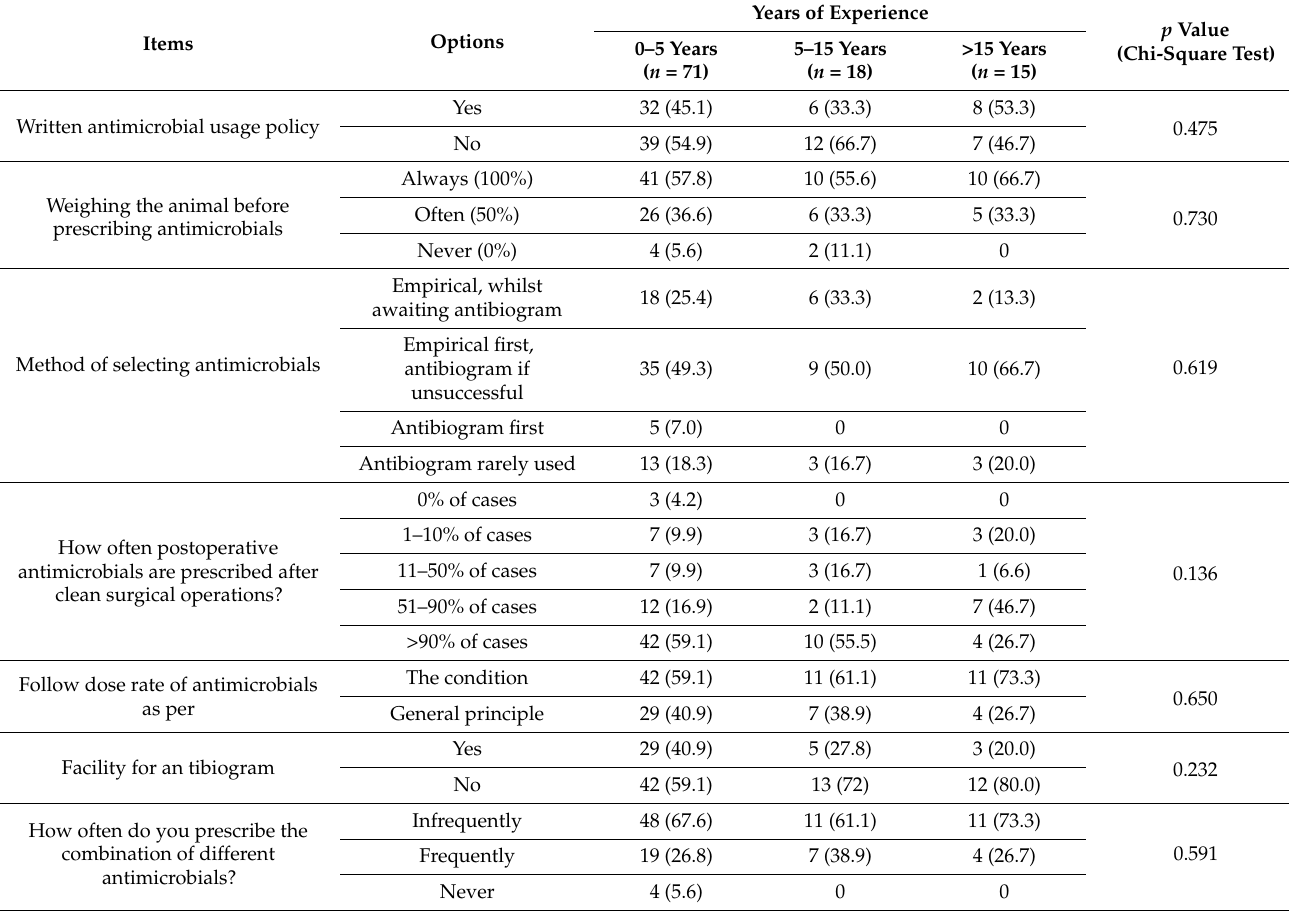
Table 4. Correlation between pet practitioner’s years of experience and other